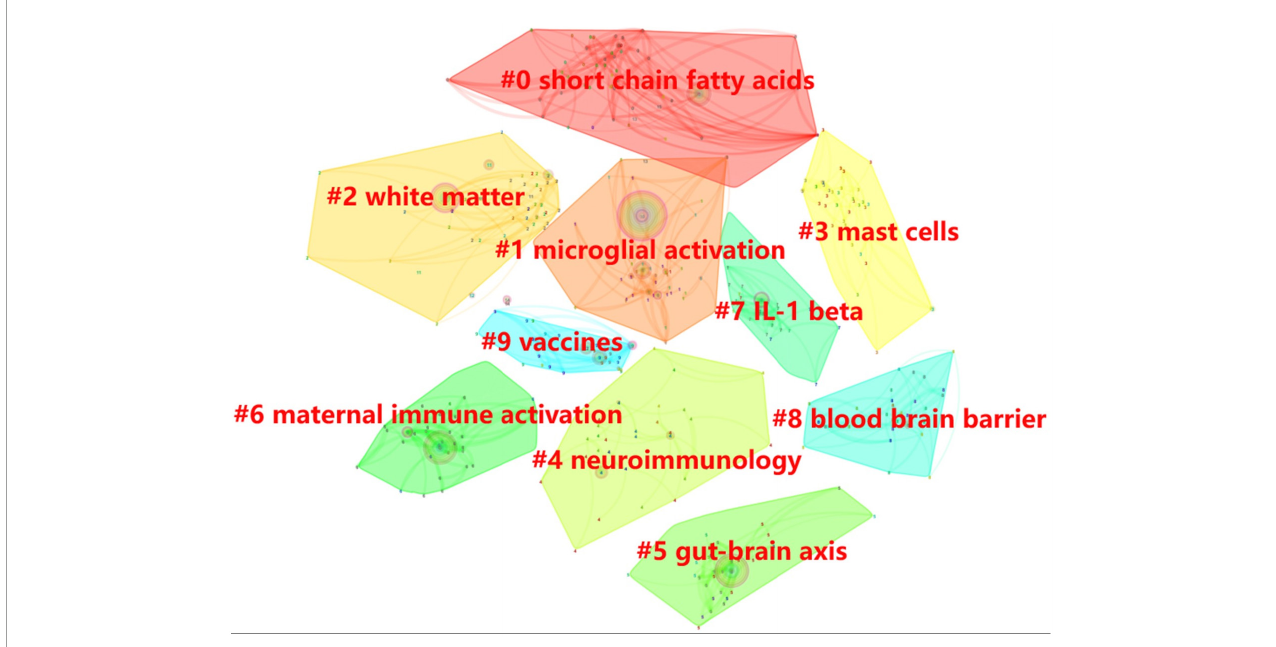
FIGURE8 Clusters of keywords: Each color block represents a cluster, and all nodes within the color block belong to the cluster. The larger the cluster number, the smaller the cluster scale.